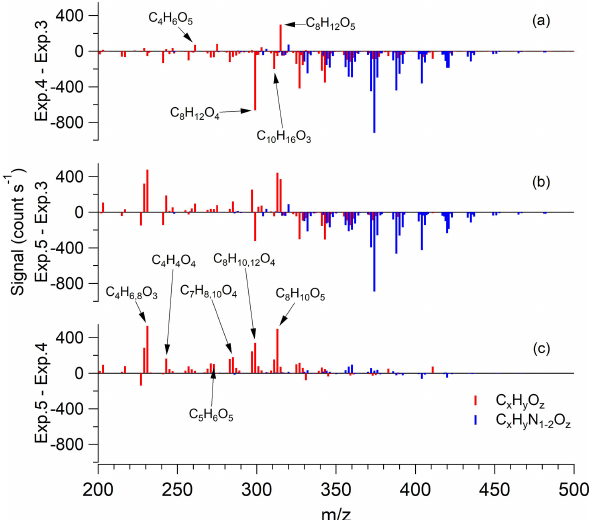
Figure 6. FIGAERO-HR-ToF-I-CIMS difference mass spectra of (cid:113) SOA in α -pinene + OH . (a) Exp. 4 (high RH, dry AS) minus Exp. 3 (low RH, dry AS). (b) Exp. 5 (high RH, wet AS) minus Exp. 3 (low RH, dry AS). (c) Exp. 5 (high RH, wet AS) minus Exp. 4 (high RH, dry AS). Bars are colored by the difference in chemical composi- tion (i.e., red for C x H y O z and blue for C x H y N 1 − 2 O z ). Prominent masses are labeled with the corresponding chemical formulae with- out an iodide